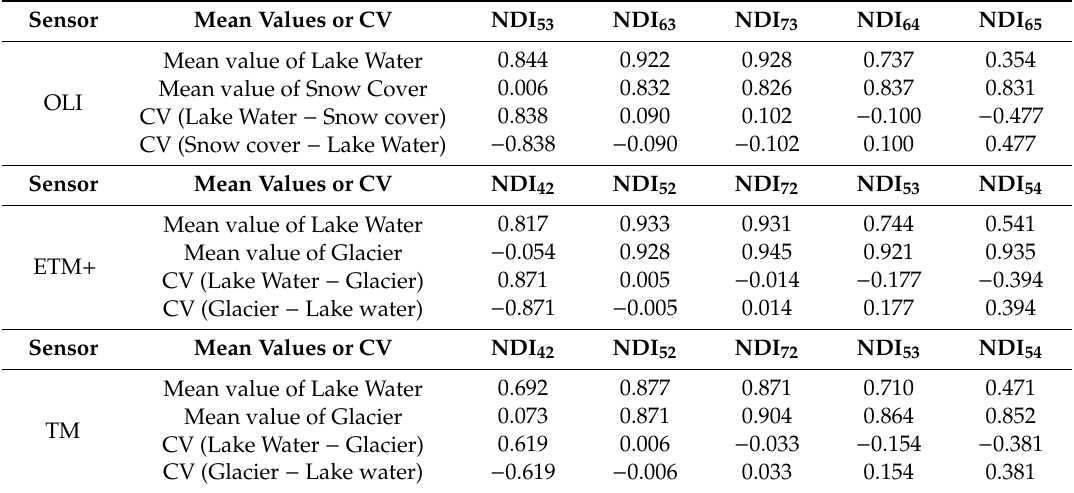
Table 4. The contrast values (CV) of five indices between lake water and snow cover / glaciers (SCG). Sensor